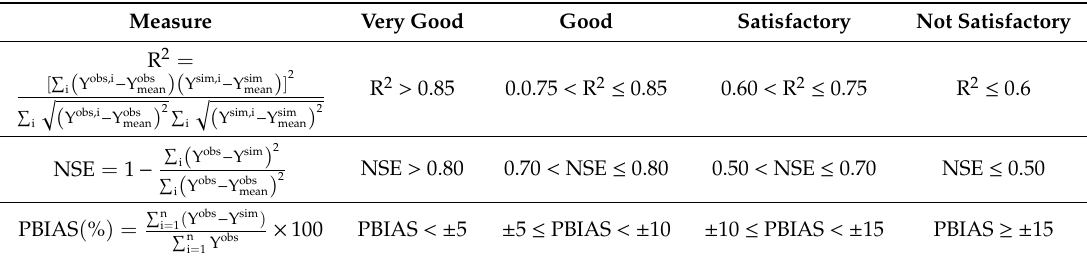
Table 4. Evaluation criteria for calibration and validation performance for the hydrologic model. Adapted from Moraisi et al.